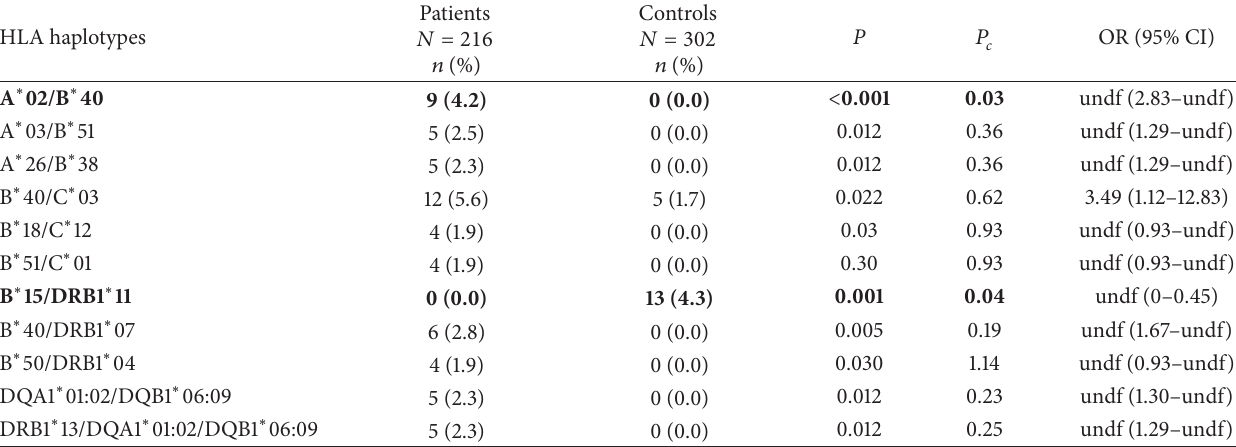
Table 4: HLA haplotype associations between chronic periodontitis patients and controls ∗ . HLA